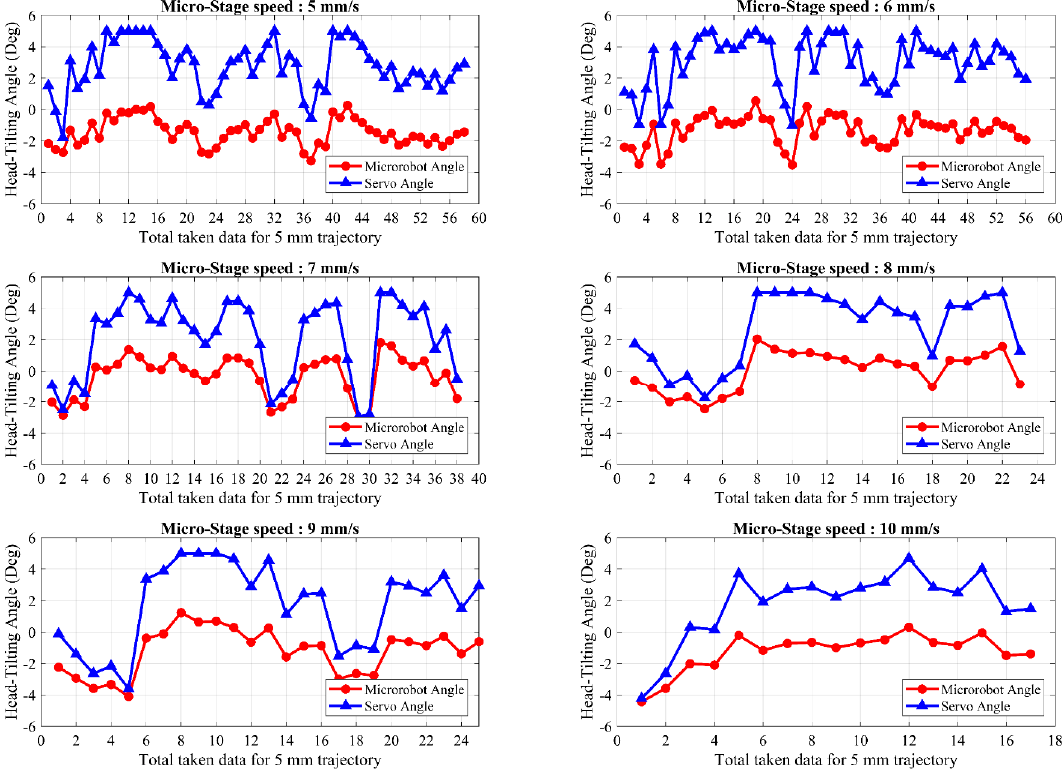
Figure 16. The microrobot head-tilting angle and the applied servo motor angle for the application of the laser model within a speed range of 5–10 mm/s.